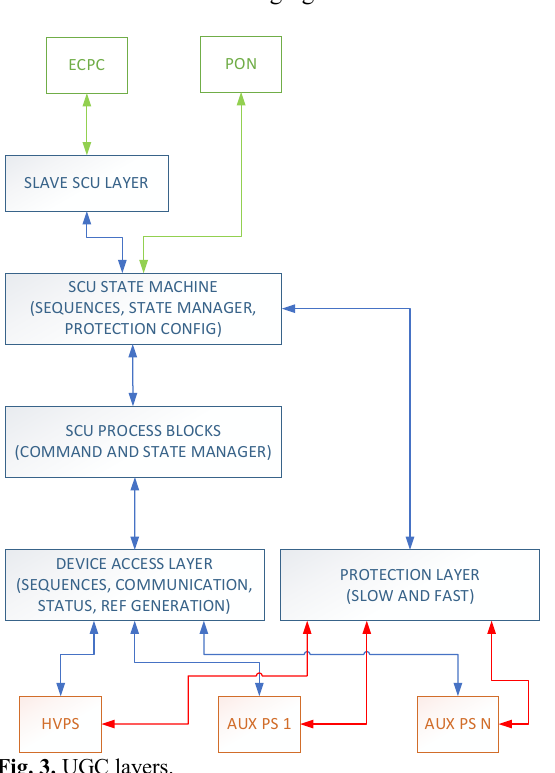
Fig. 3. UGC layers.